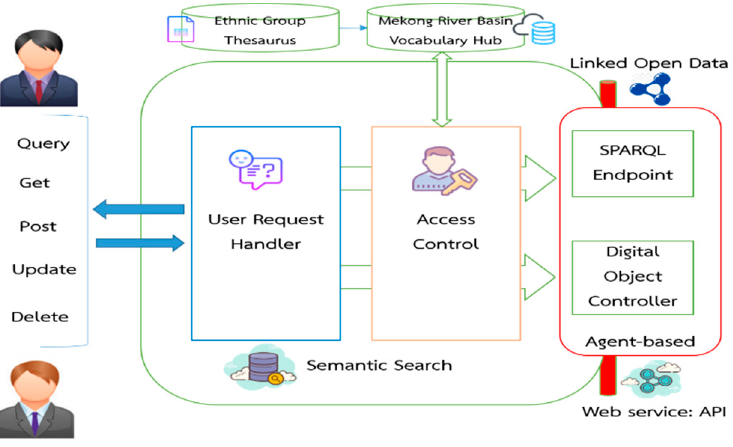
Figure 3. Architecture of the digital platform for the thesaurus of ethnic groups in the MRB. 4.